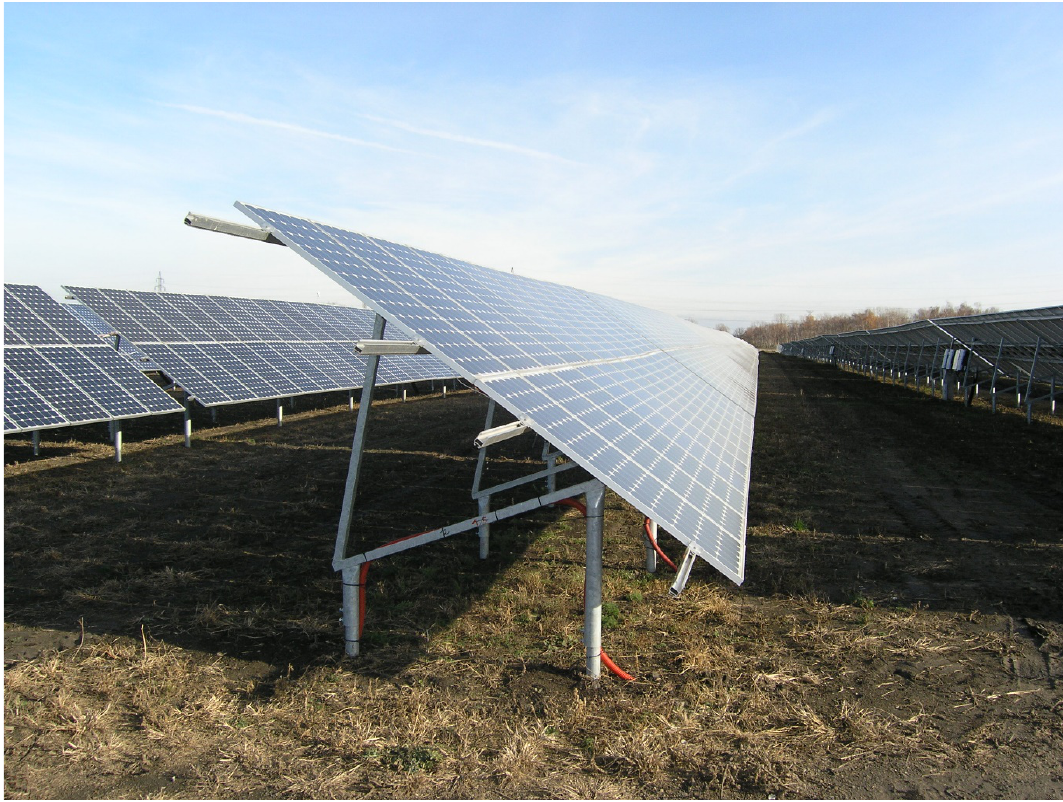
Figure 6. Photovoltaic array at Měnín.